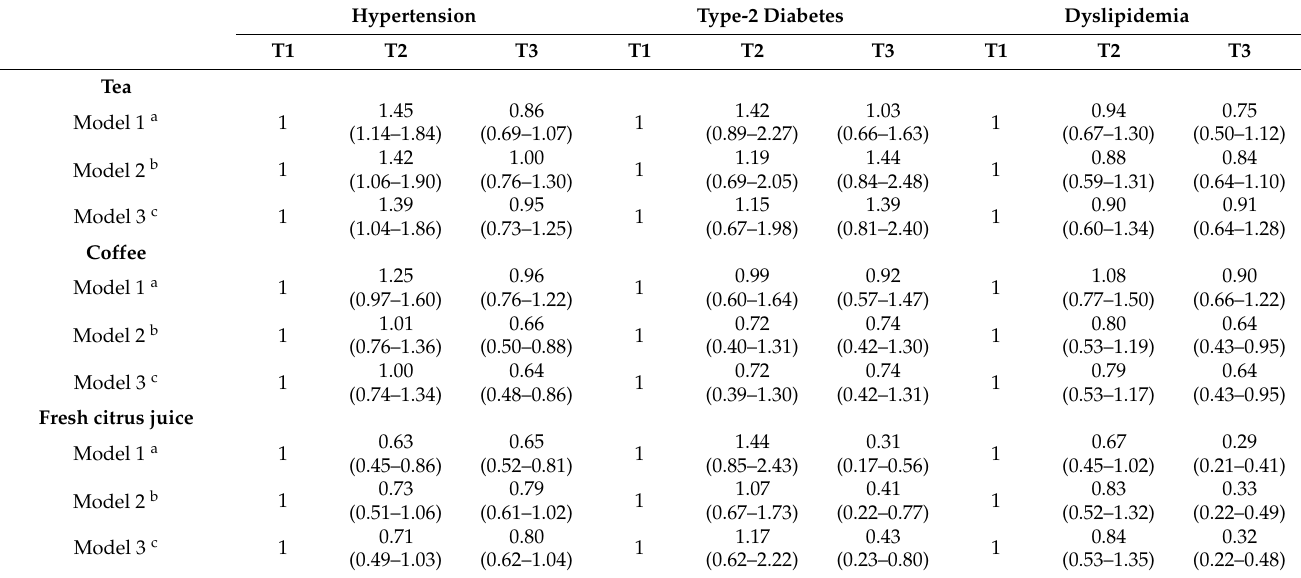
Table 5. Association between polyphenol-rich beverages consumption and metabolic outcomes in the study sample.